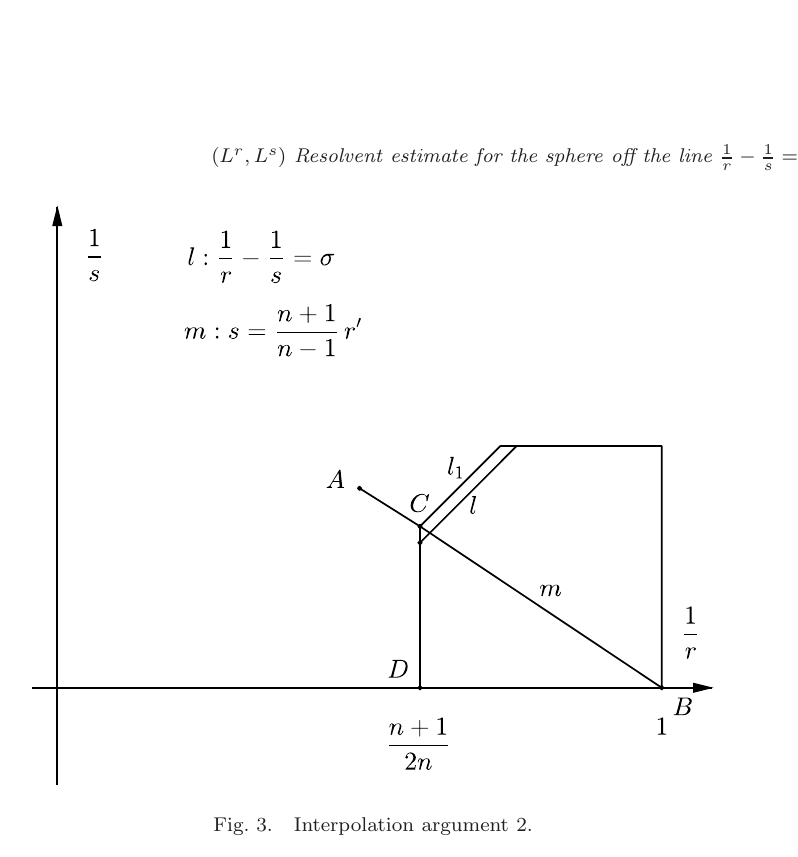
Fig. 3. Interpolation argument